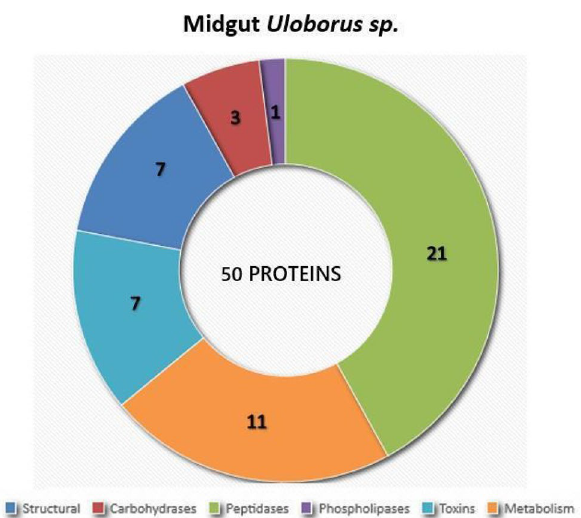
Figure 3. The amount and protein categories by Uloborus sp . midgut proteome. Proteins were set apart into six different categories and their amount in Uloborus sp . midgut proteome: structural (7), carbohydrases (3), peptidases (21), phospholipases (1), toxins (7) and metabolism (11), summing a total of 50 proteins. Plot was generated in